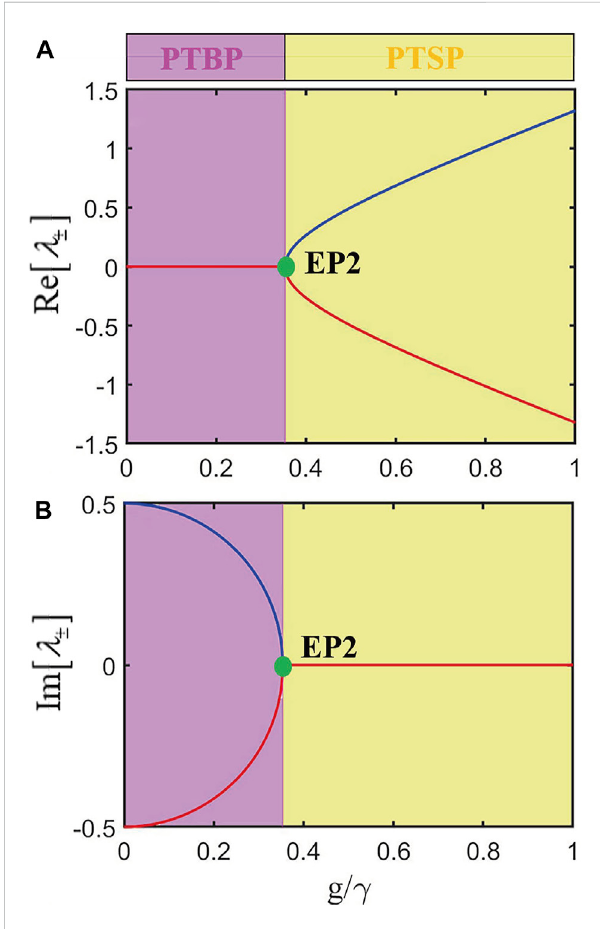
FIGURE 4 (A) Real and (B) imaginary parts of the eigenvalues are obtained by Eq. 12 with κ (cid:1) − γ versus the same coupling strength g (i.e.; g 1 (cid:1) g 2 (cid:1) g ). Green dots show the position of EP2 when Δ (cid:1) 0. The pink and yellow areas represent the PT-symmetric phase (PTSP) and PT-symmetry-broken phase (PTBP) area,